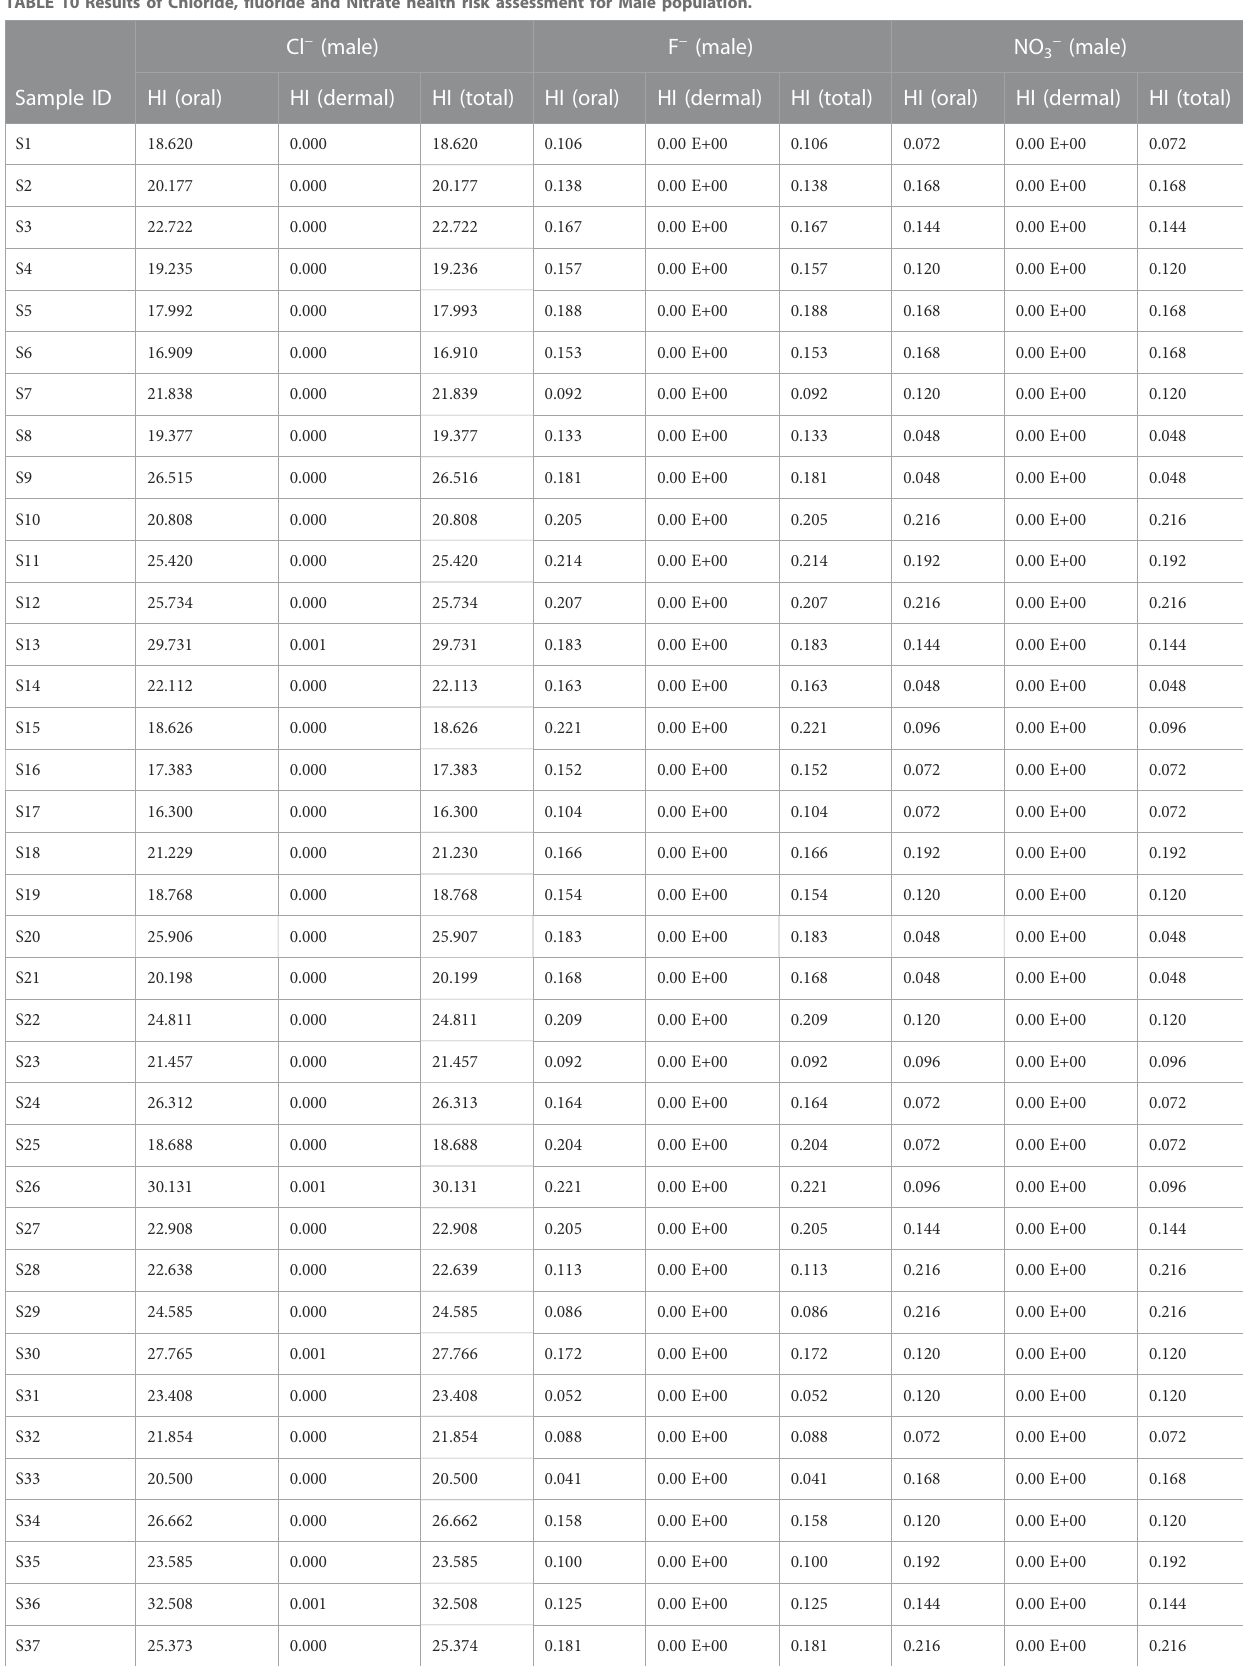
TABLE 10 Results of Chloride, fl uoride and Nitrate health risk assessment for Male population. Cl −